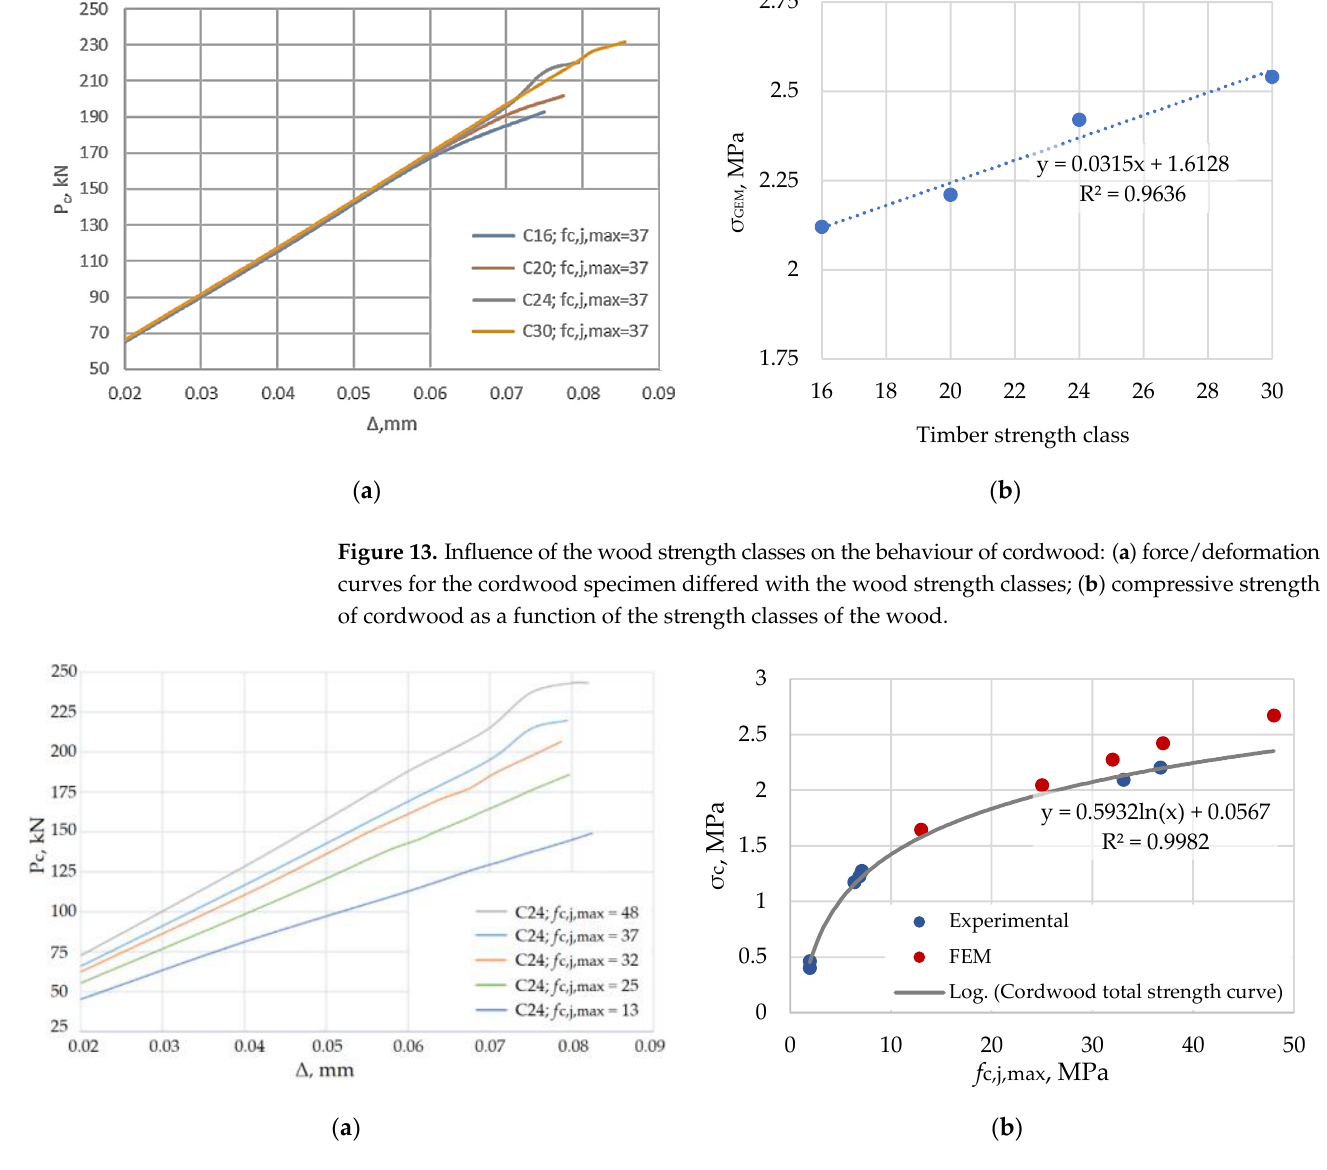
Figure 14. Influence of the mortar compressive strength on the behaviour of cordwood: ( a ) force/deformation curves for the cordwood specimen differed with the mortar compressive strength; ( b ) compressive strength of cordwood as a function of the compressive strength of mortar.